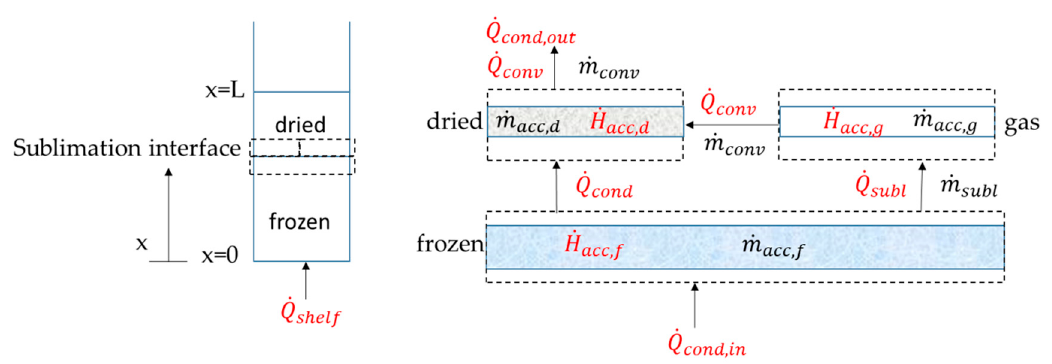
Figure 8. Balance volumes–energy and mass.